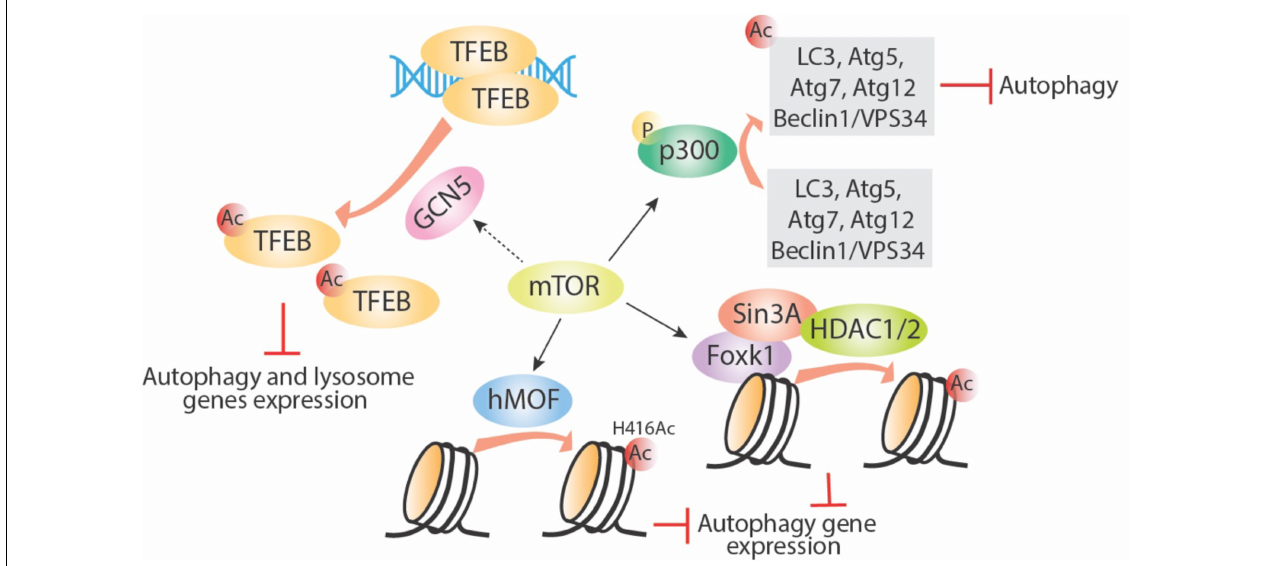
FIGURE 3 | mTOR regulates autophagy via targeting acetyltransferases. mTOR can enhance activity of acetyltransferases including p300, GCN5, and hMOF. Phosphorylation of p300 directly acetylates several important autophagy-related proteins and inhibits their function; GNC5 acetylates TFEB and inhibits its downstream autophagy and lysosome gene expression; hMOF acetylates histone proteins directly and inhibits autophagy gene expression; mTOR also increase Foxk1 nuclear location, then the Foxk1 recruits Sin3A-HDAC1/2 complex to chromatin and subsequently decreases autophagy gene expression. Ac, acetylation; P,